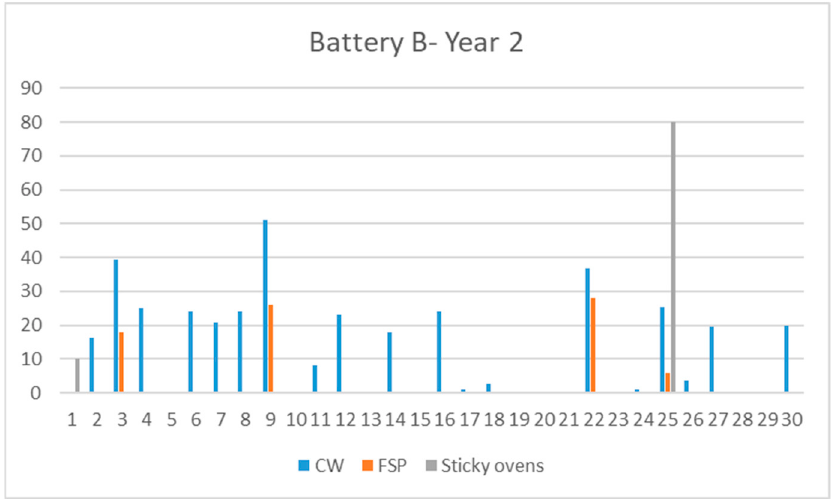
Figure 15. Sticky ovens and refractory repairs battery B, year 2.